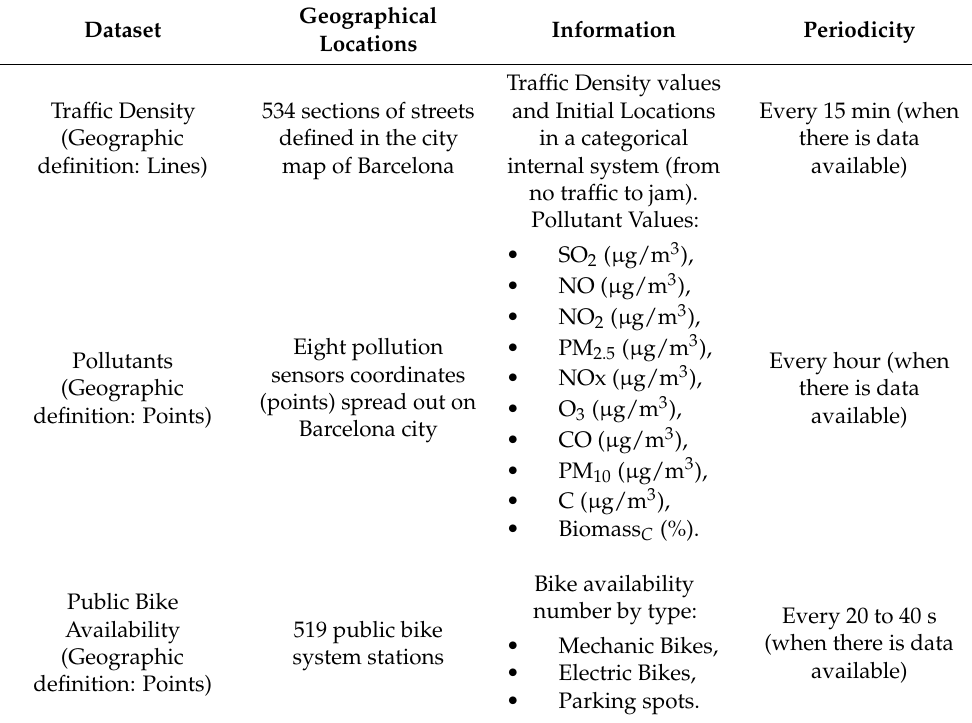
Table 2. Datasets used in the case